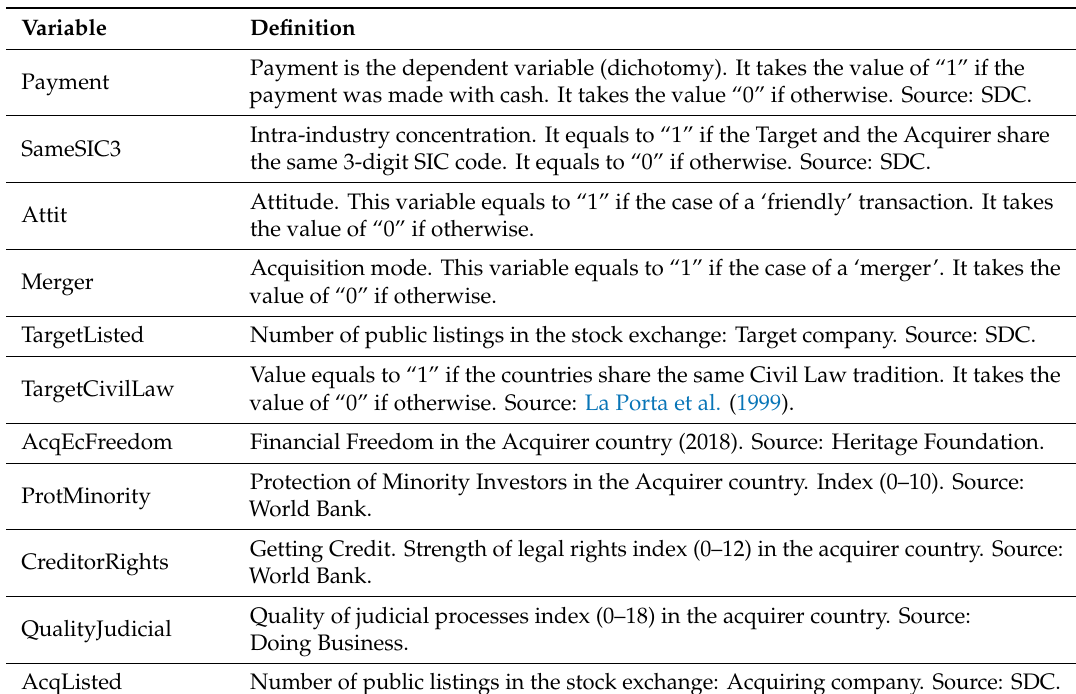
Table 2. Variable